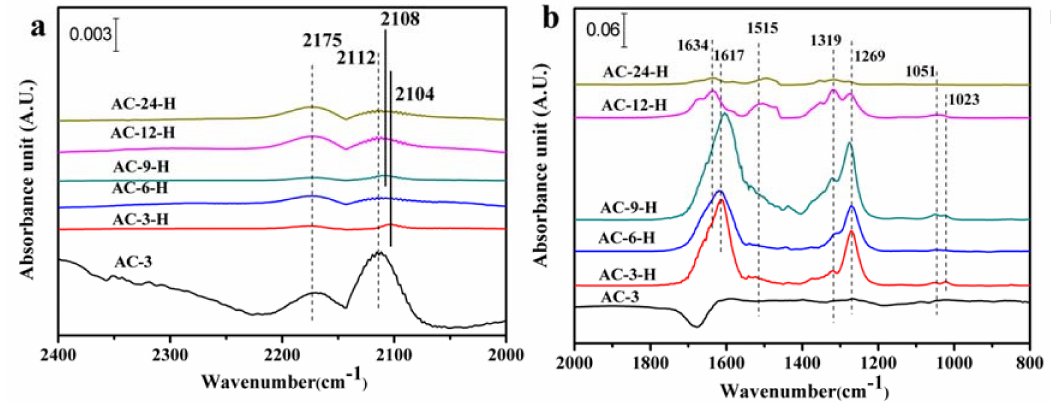
Figure 6. In-situ DRIFT spectra of CO adsorbed on Au-CeO 2 samples at 25 ◦ C after 20 min in